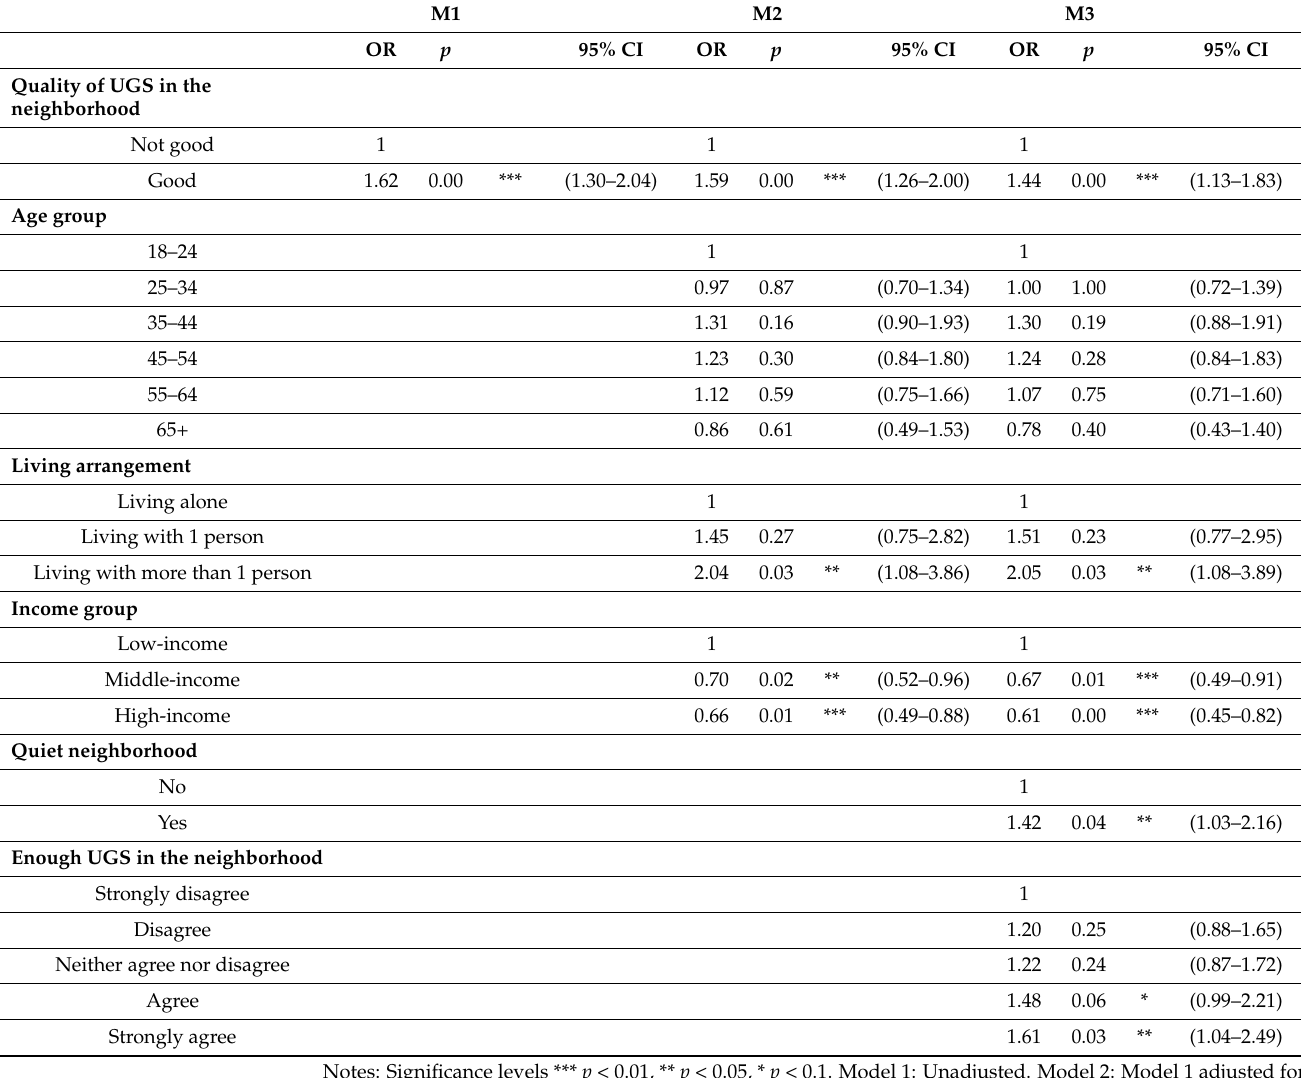
Table 2. Odds ratios and 95% confidence intervals for predictor variables associated with UGS use (access) after COVID-19 restrictions were introduced (21 March 2020), online survey of women living in Mexico City ( n = 1245), June